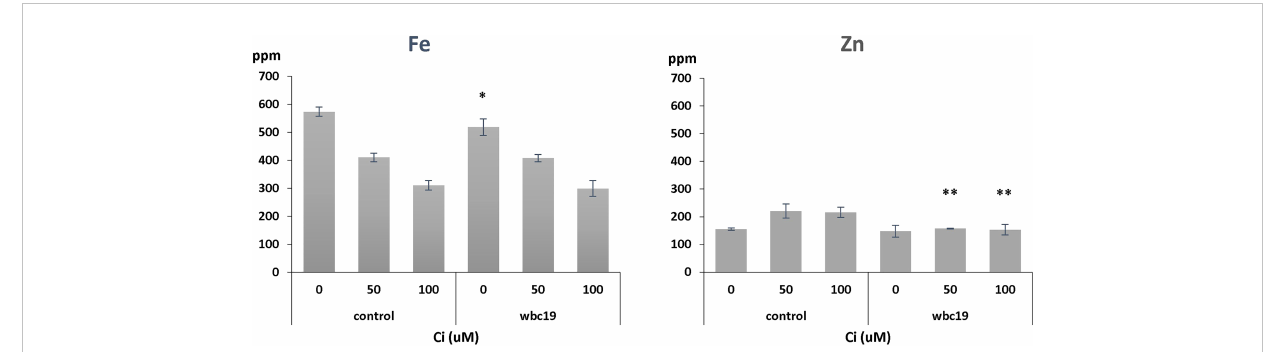
FIGURE 3 Iron and zinc concentrations in control and wbc19 mutants grown for 10 days on MS medium supplemented with 0, 50,100 m M Ci. ppm = part per million. Error bars represent standard deviation. * and ** indicate signi fi cantly different (p<0.05 and p<0.01 respectively) from control under the same experimental conditions (Student t